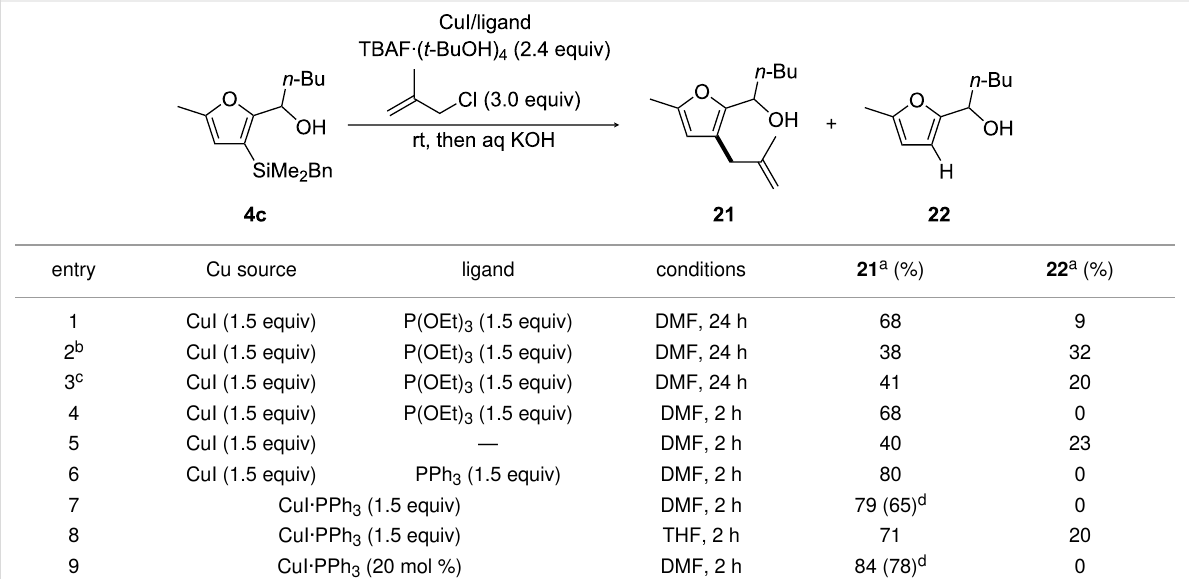
Table 1: Optimization of the reaction conditions for Cu-catalyzed methallylation of 2-[(3-benzyldimethylsilyl)furyl] carbinol 4c .